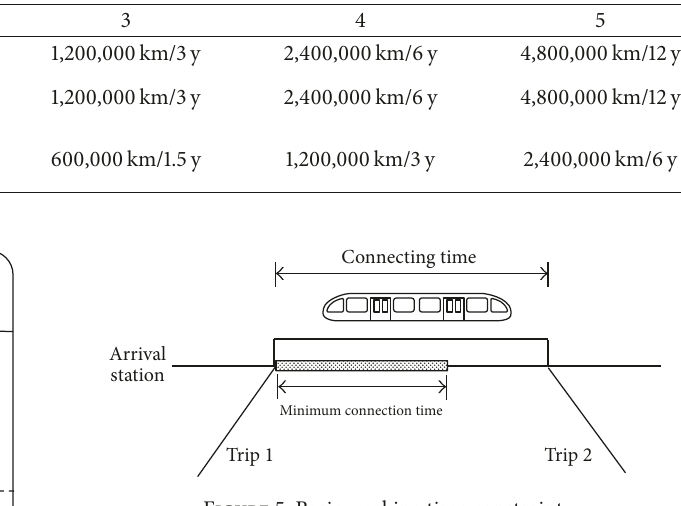
Figure 5: Basic working time